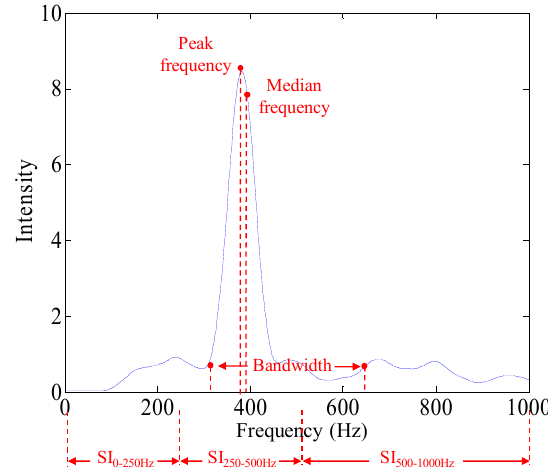
Figure 5. Illustration for quantitative information of breathing sounds.